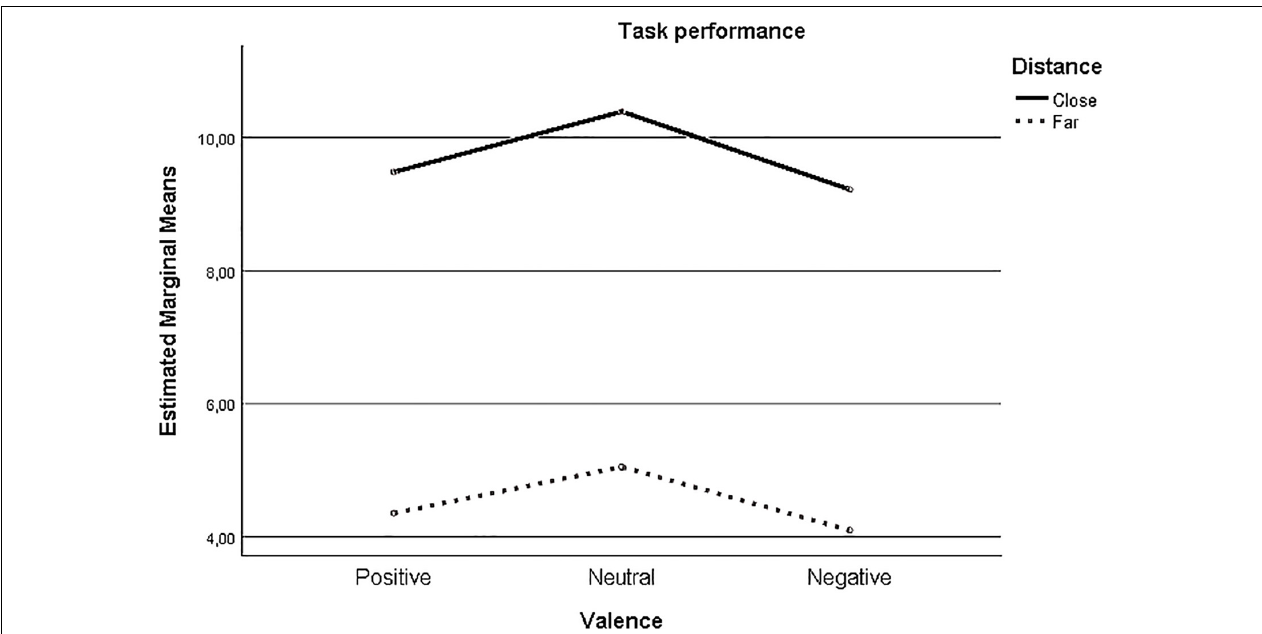
FIGURE 4 | Task performance. Note: estimated marginal means for the 3 Valence (Positive vs Neutral vs Negative) × 2 Distance (Far vs Close) interaction on the number of correctly localized target stimuli are displayed on the y -axis.